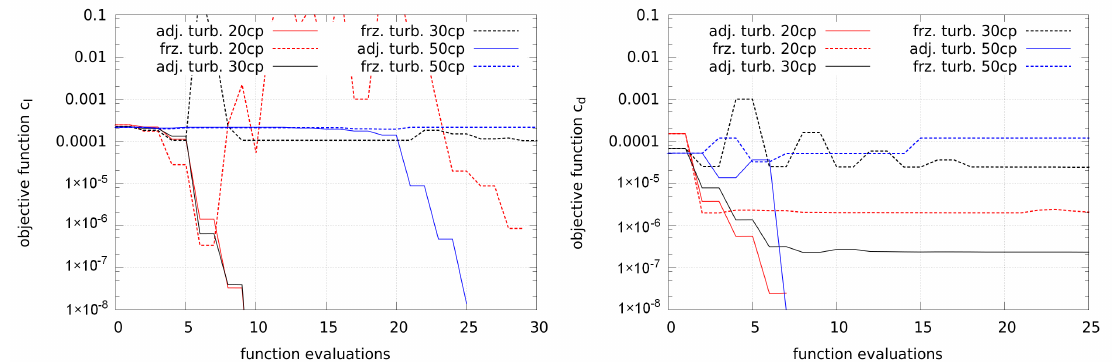
Figure 10. Objective functions for lift and drag as in Equation (14) along the number of function evaluations for the NACA 0012 at AoA = 12 ◦ . Frozen as well as adjoint turbulence are used. The number of control points is labeled as “XXcp”.